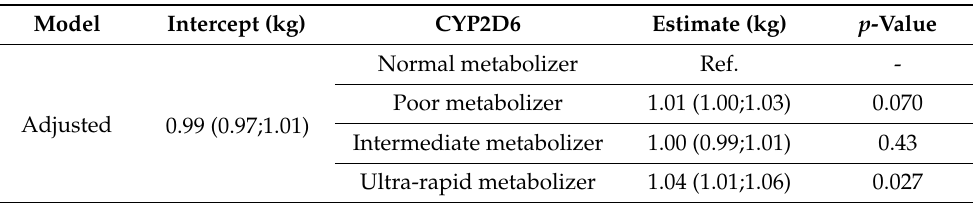
Table 5. Multiple linear regression and relative weight change.